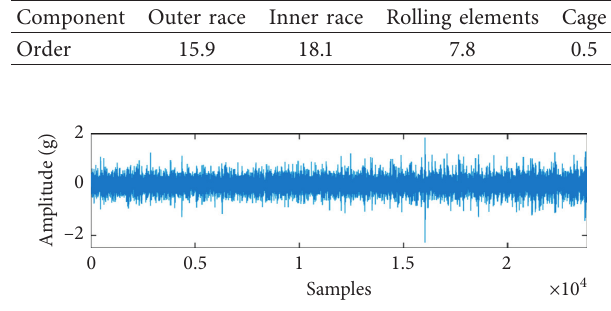
Figure 19: The angular signal of outer race fault.